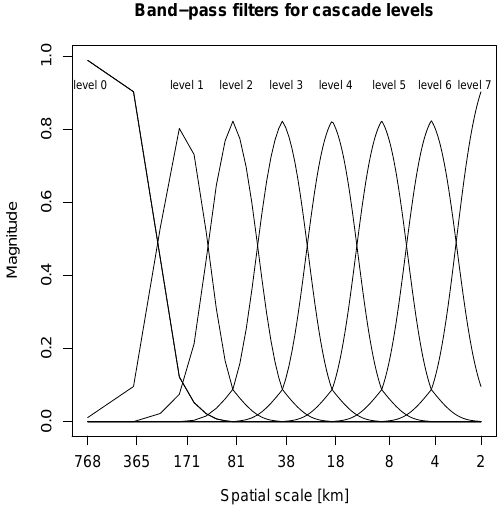
Figure 2. The set of eight Gaussian band-pass filters used to iso- late the spatial frequencies composing the cascade levels. The total magnitude for a given spatial frequency is normalized to one.